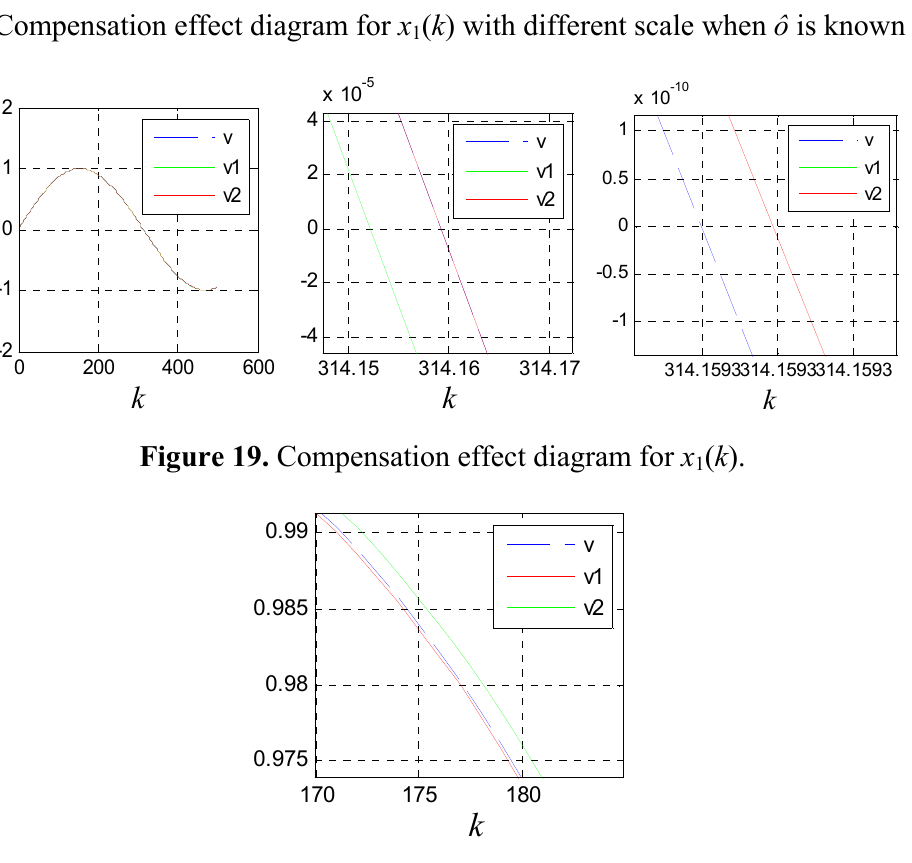
Figure 17. Compensation effect diagram for x